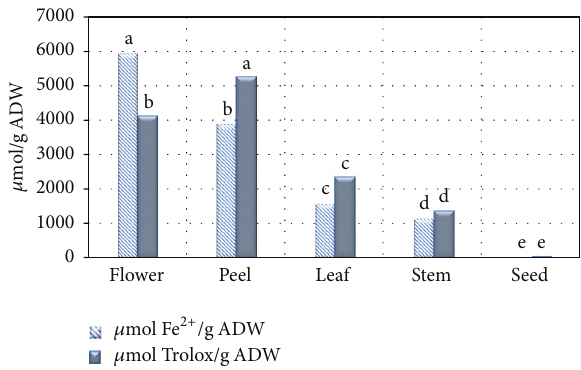
Figure2:TEACandFRAPvaluesofdifferentpomegranateextracts. ADW: air dry weight. Different superscripts between columns represent significant difference between extracts. Data expressed as mean ± standard deviation 𝜇 mol Trolox equivalent/g air dry weight for TEAC ( 𝑛 = 3 ); LSD = 920.44, at 5% significance. Data expressed as mean ± standard deviation 𝜇 mol Fe 2+ /g ADW for FRAP ( 𝑛 = 3 ); LSD = 101.34, at 5%